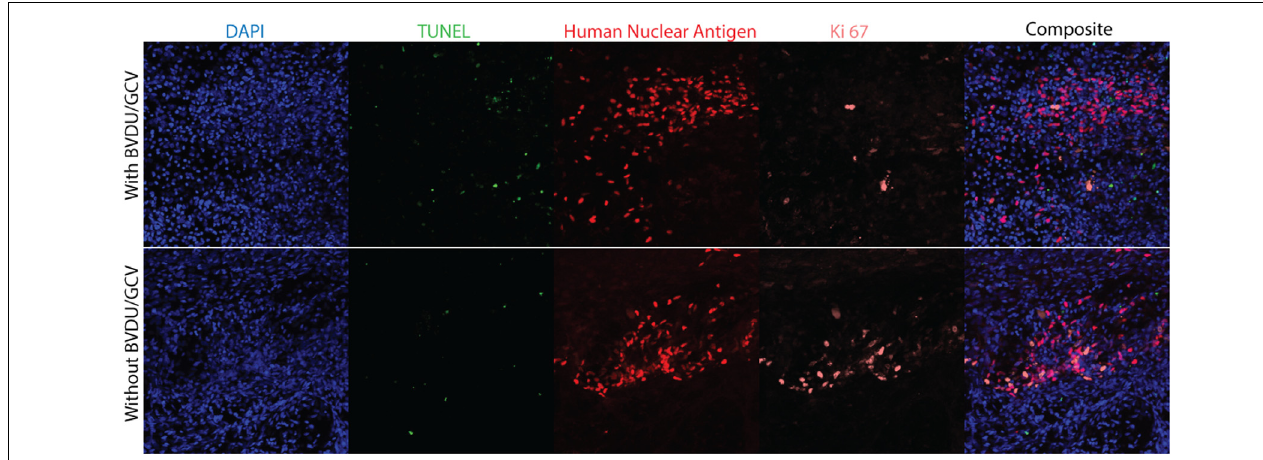
FIGURE 6 | Immunohistology of cell grafts with and without prodrug treatment. Rat spinal cords were collected 16 days post-transplantation, with the ablation animal group receiving 4 days of GCV and BVDU treatment before being sacrificed ( n = 3). To visualize cell nuclei, apoptotic cells, transplanted NPCs, and actively proliferating cells, the spinal cord sections were stained with DAPI, a fluorescein TUNEL kit, human nuclear antigen, and Ki-67